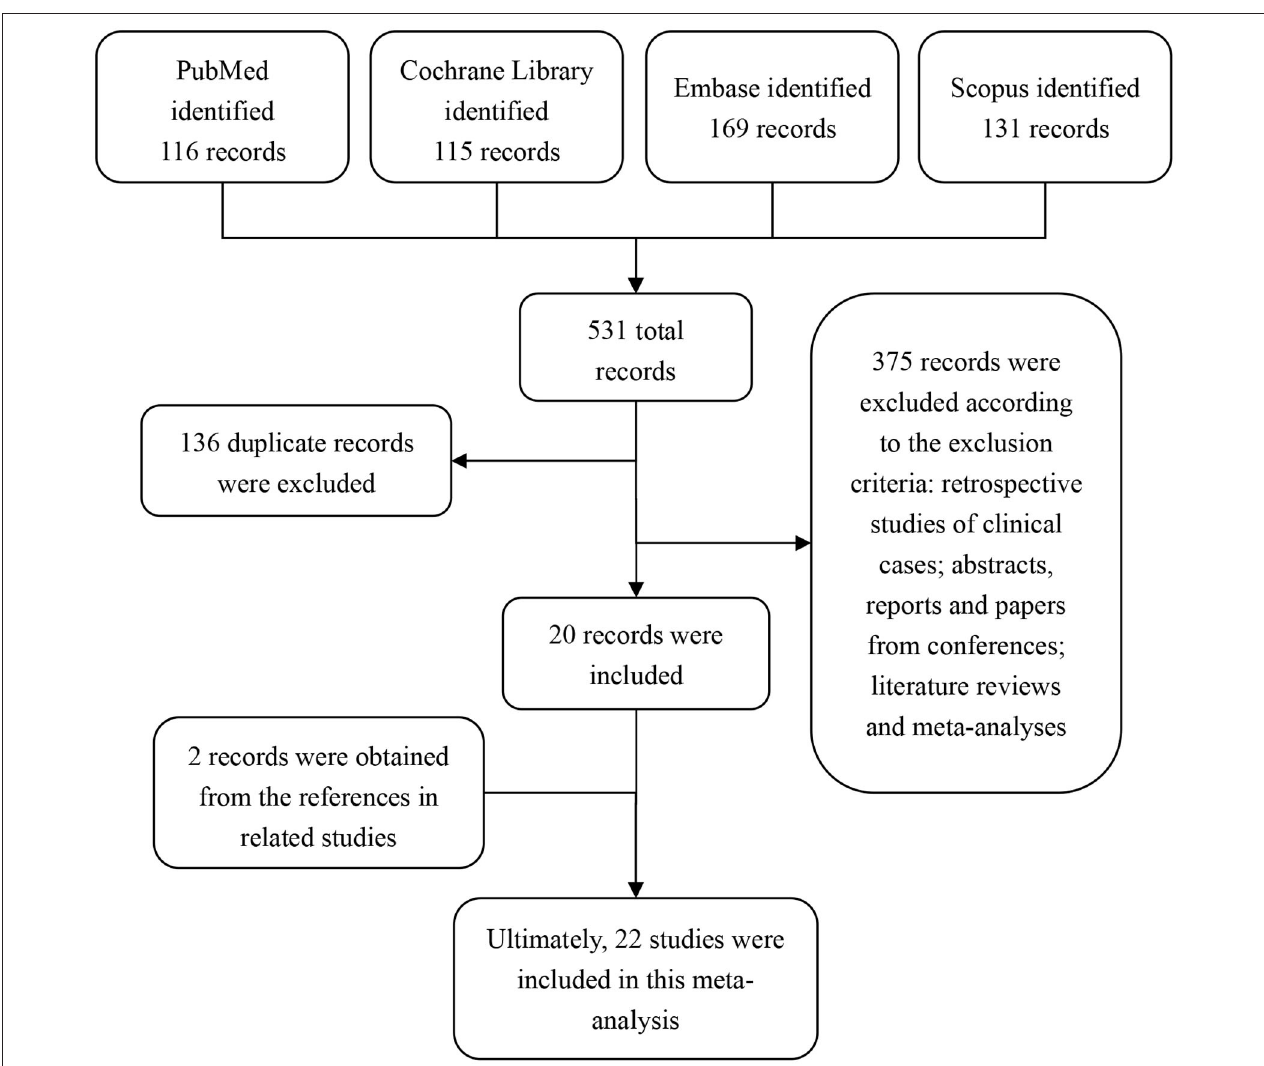
FIGURE 1 | Flow diagram of the study